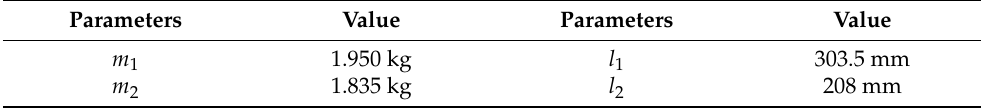
Table 1. Parameters of 2-DOF